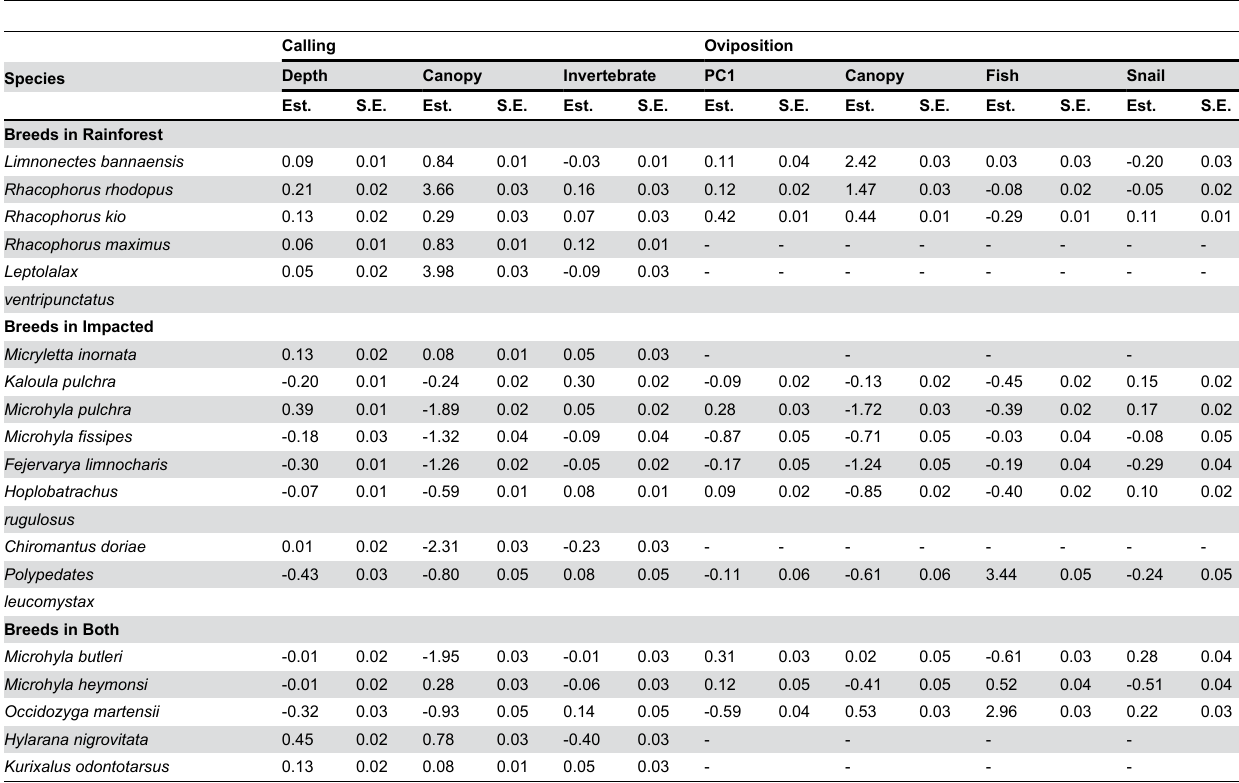
Table 3. Multilevel model effect size estimates (Est.) and standard errors (S.E.) for each frog species with respect to environmental variables identified in partial correspondence analyses to significantly impact calling and